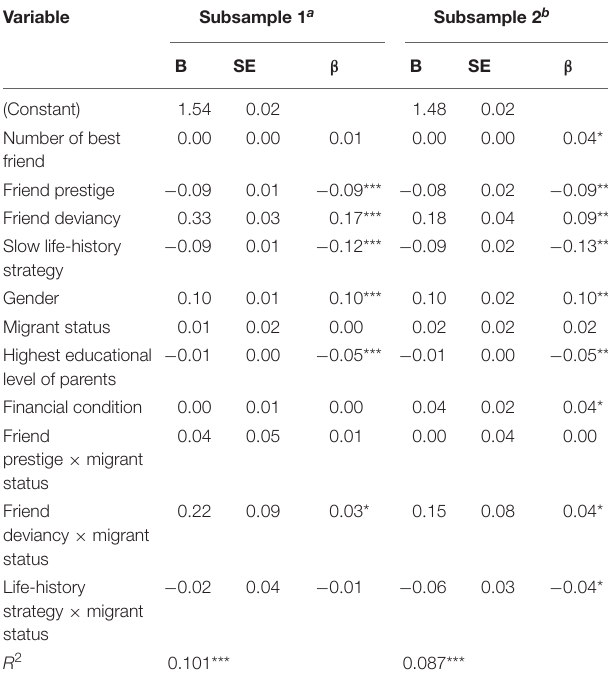
TABLE 3 | Results of multiple linear regression analysis for prosocial actions. TABLE 4 | Results of multiple linear regression analysis for antisocial